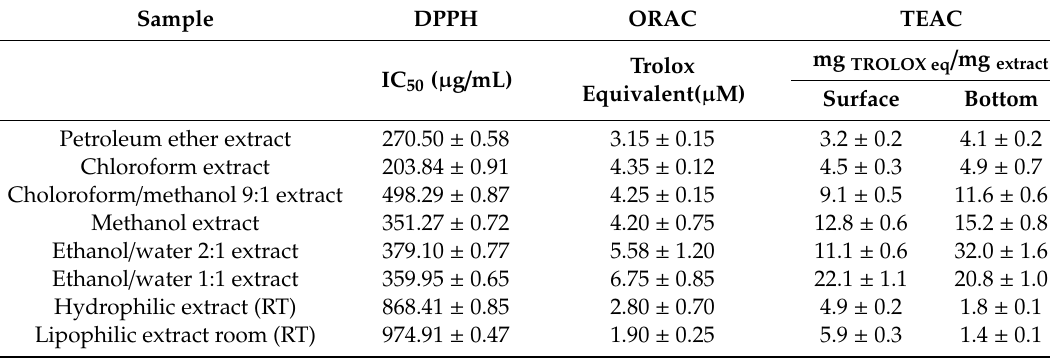
Table 6. Antioxidant activity of bioglea extracts in